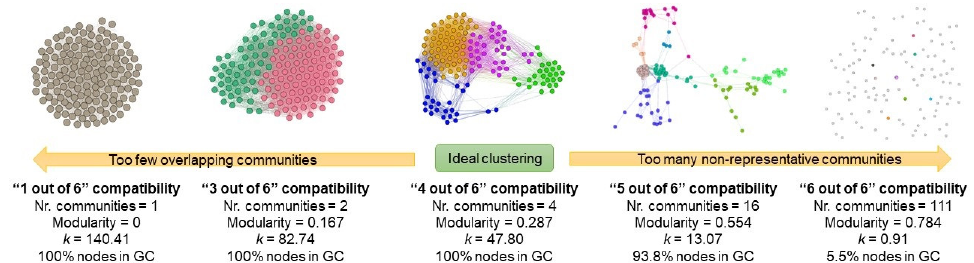
Figure 2. Ideal compatibility threshold of “at least 4 out of 6” common parameter classes used in the modeling of the CPAP patient network. If a lower threshold is used (i.e., less strict), too few, dense, and overlapping communities emerge. Conversely, if a higher threshold is used (i.e., more strict), too many non-representative communities emerge, and many nodes become completely disconnected from the giant component (GC) of the